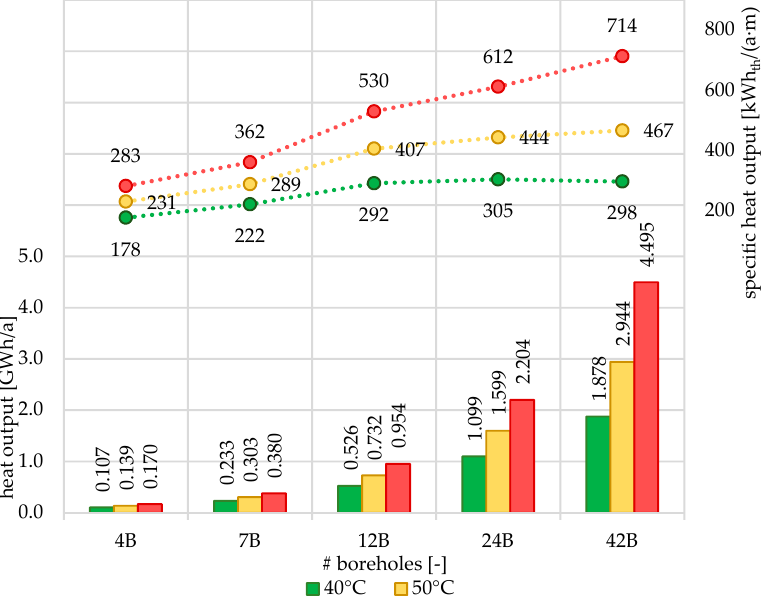
Figure 31. Specific heat output (top) and annual heat output (bottom) by configuration and charging temperature.